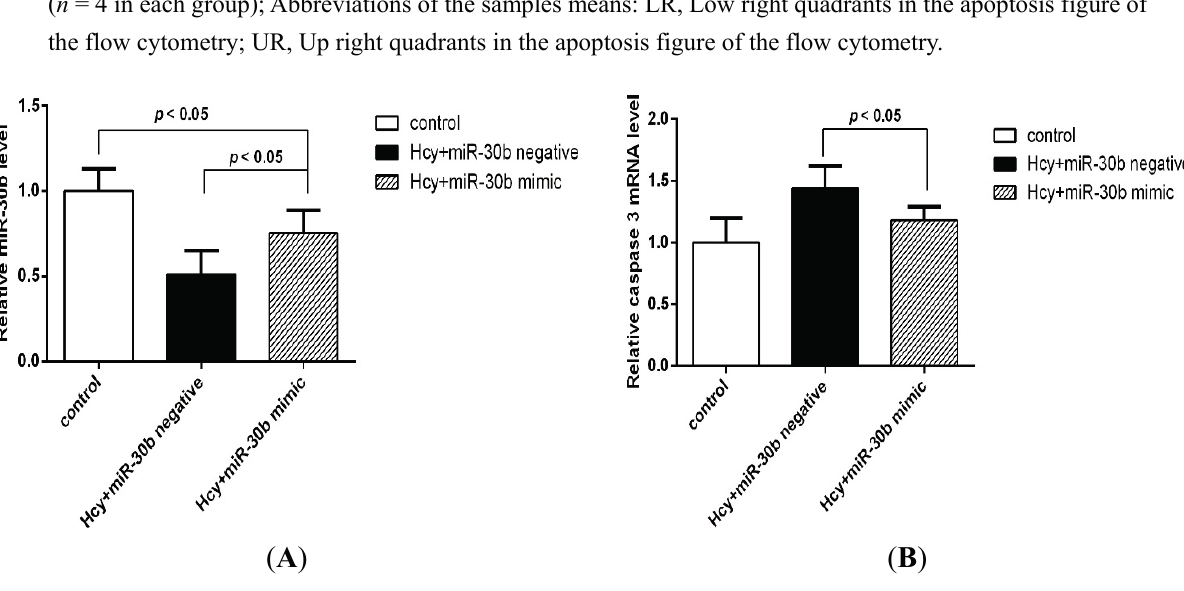
Figure 6. The expression of miR-30b and caspase-3 mRNA after overexpression of miR-30b in Hcy-induced HCAECs. The concentration of Hcy was 1 mmol/L, both the time of transfection and treatment of Hcy were 24 h. ( A ) shows the transfection of miR-30b mimic significantly up-regulated the expression of miR-30b which Hcy reduced; and ( B ) shows the overexpression of miR-30b down-regulated the expression of caspase-3 mRNA which Hcy induced. Compared with the control group, compared with the Hcy + miR-30b negative group, p < 0.05, n = 6 in each